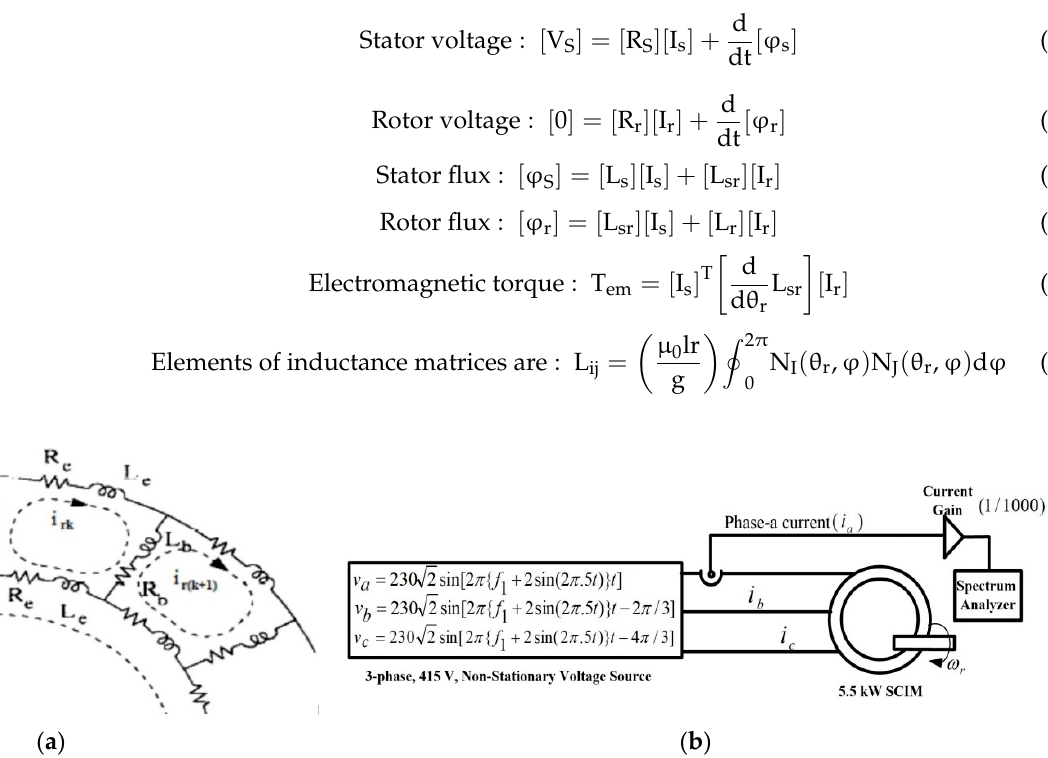
Figure 1. Simulation and modelling of SCIM: ( a ) Current distribution in rotor loops using the winding function theory, and ( b ) block diagram of MATLAB/Simulink model of variable frequency voltage fed SCIM.